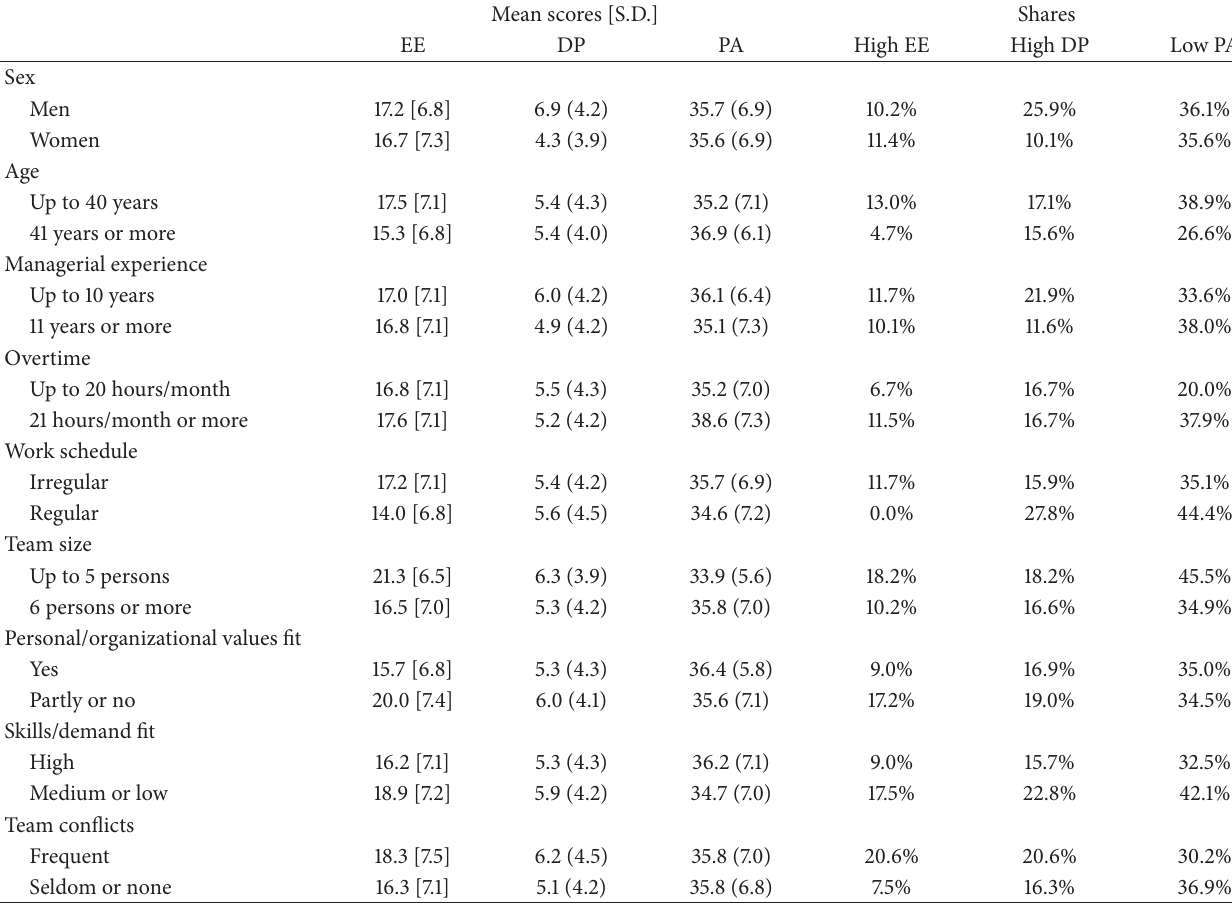
Table 2: Mean scores and prevalence of burnout according to the MBI-HSS subscales among nursing managers. Mean scores [S.D.]